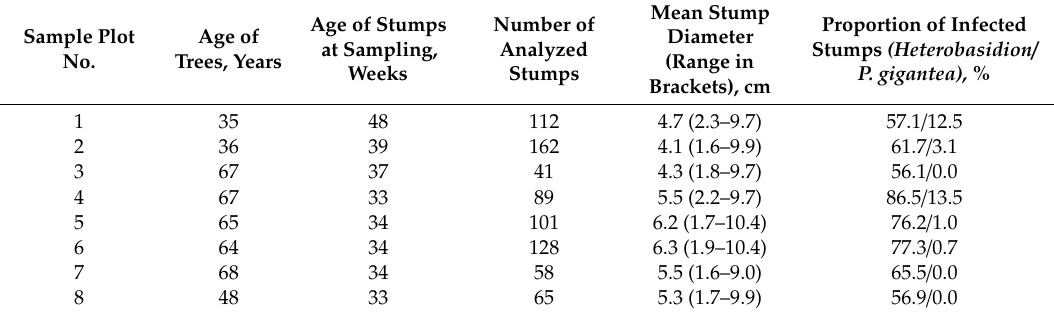
Table 1. Characteristics of sample plots, analyzed stumps and occurrence of Heterobasidion spp. / Phlebiopsis gigantea